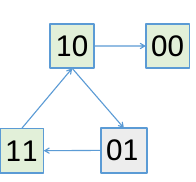
Figure 3. Victory graph for the Penney Game with (cid:96) = 2 and loaded coins ( p =